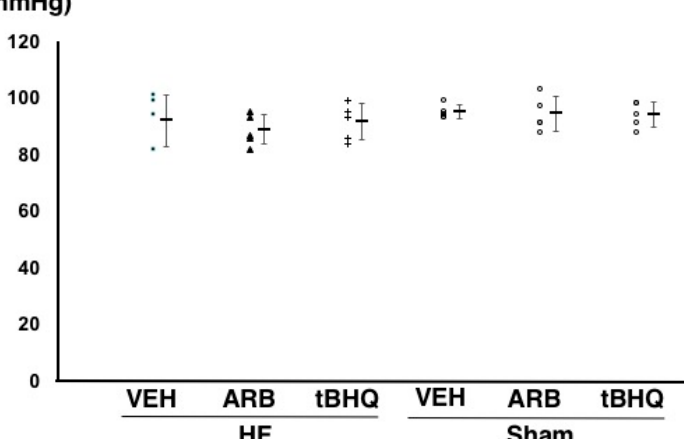
Figure 1. Mean arterial pressure of heart failure treated with intracerebroventricular (ICV) infusion of vehicle (HF-VEH), or with ICV infusion of angiotensin II type 1 receptor blocker (HF-ARB), or with ICV infusion of nuclear factor erythroid 2-related factor 2 activator, tert -butylhydroquinone (HF-tBHQ), or sham treated with ICV infusion of VEH, or with ICV infusion of ARB, or with ICV infusion of tBHQ. All data are shown in dot plot and mean ± standard deviation. n = 5 for each group.